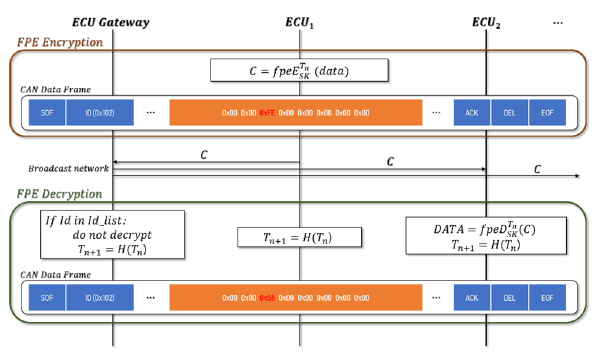
Figure 5. Encryption and Decryption using the format-preserving encryption (FPE).